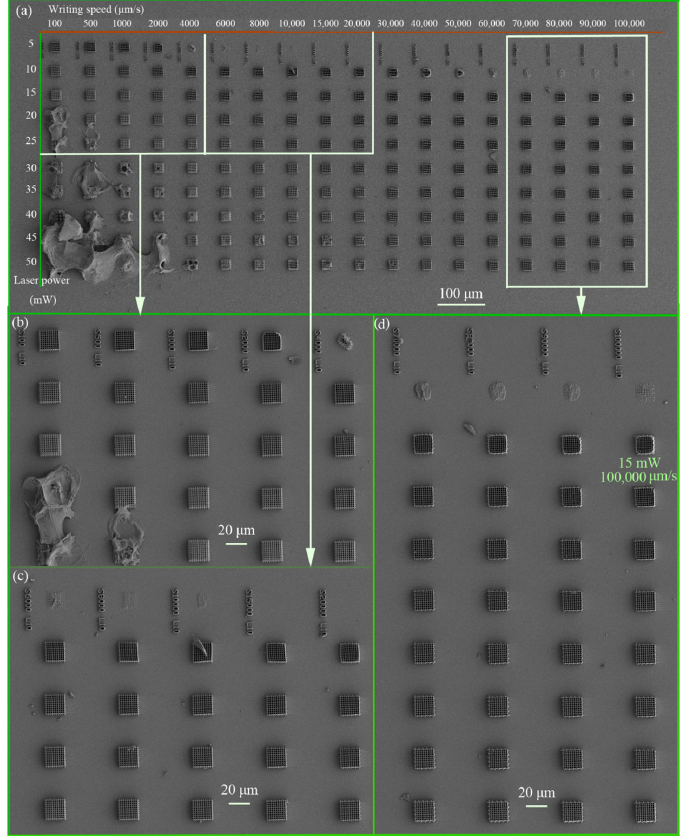
Figure 9. ( a ) SEM images of structures with initiators BM-PPPM-C6 in PETA, 10 µ mol/g. ( b – d ) Enlarged images of the area